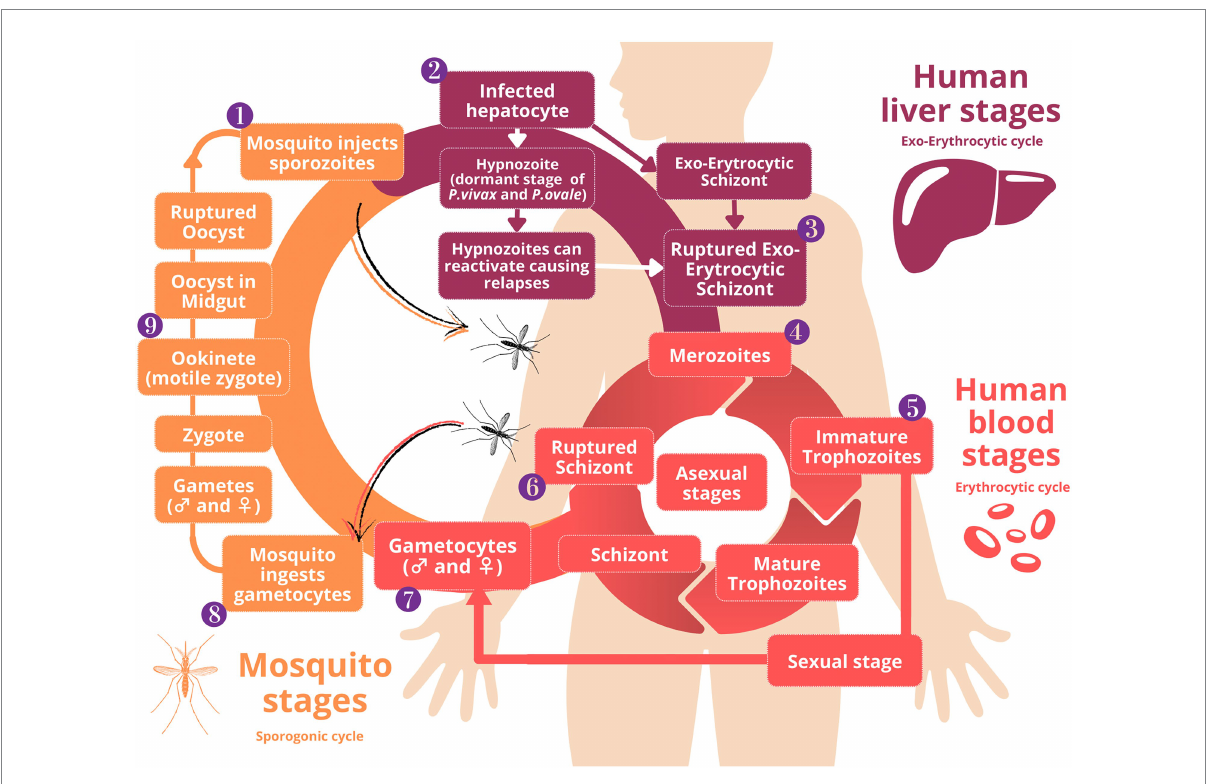
FIGURE 1 Life cycle of the Plasmodium parasite. Mosquito, human liver, and human blood stages are represented. (1) Mosquito injects sporozoites; (2) Infected hepatocyte; (3) Ruptured exo-erytrocytic schizont; (4) Merozoites in peripheral blood; (5) Immature trophozoites in peripheral blood; (6) Ruptured schizont; (7) Some immature trophozoites develop into sexual precursor cells named gametocytes; (9) Ookinete (motile